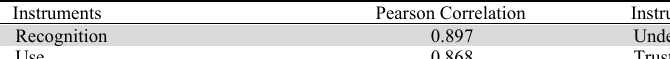
Instrument Tests for Eco-Label (Cronbach’s Alpha = 0.825) Instruments